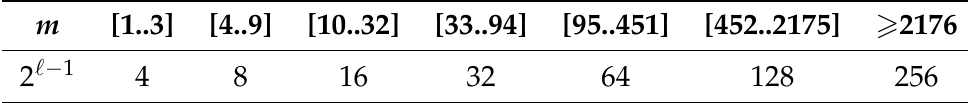
Table 2. Recommended number of transactions in a block 2 (cid:96) − 1 , corresponding to the probability of block creation 1 − ε = 0.95 (for a different numbers of provers)